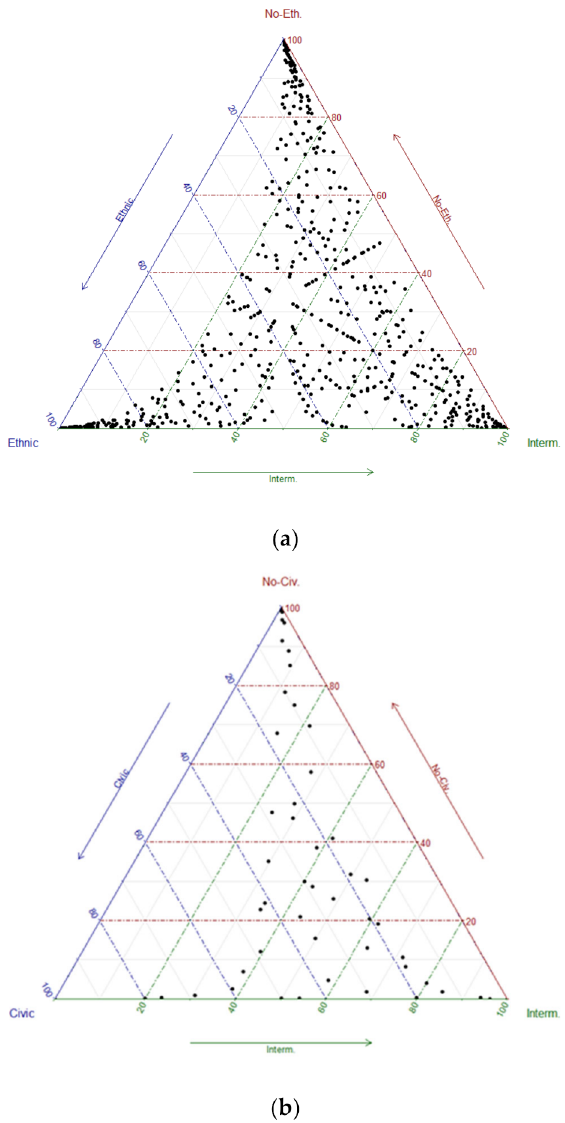
Figure 1. Fuzzy clustering ternary graphs. ( a ) Ethnic national identity; ( b ) civic national